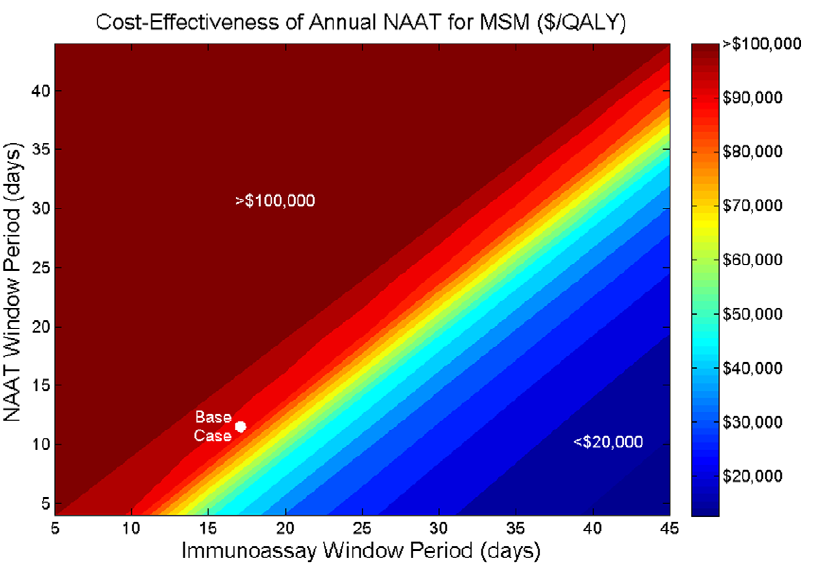
Figure 2. Two-way sensitivity analysis on the window period of detection. The cost-effectiveness of annual NAAT testing of MSM, given simultaneous variations in the window periods of detection for the immunoassay and NAAT, assuming the immunoassay detects infection after NAAT. Cost-effectiveness is relative to annual screening with immunoassay only. MSM = men who have sex with men; NAAT = nucleic acid amplification test; QALY = quality-adjusted life year.